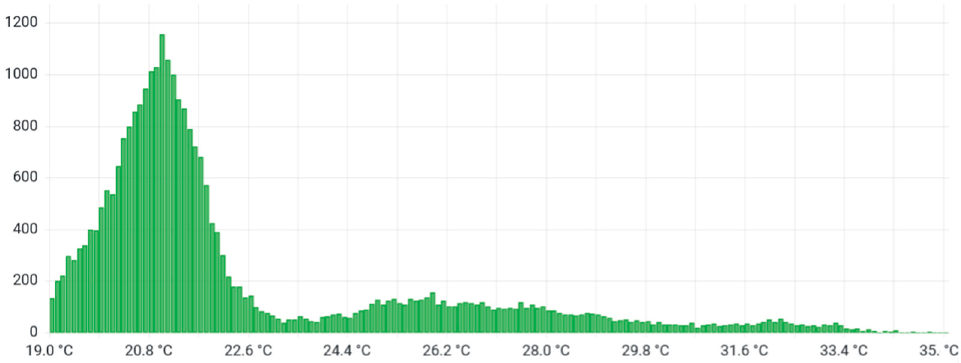
Figure 5. Indoor temperature histogram for a 2001–2010 building, with second-order penalty.